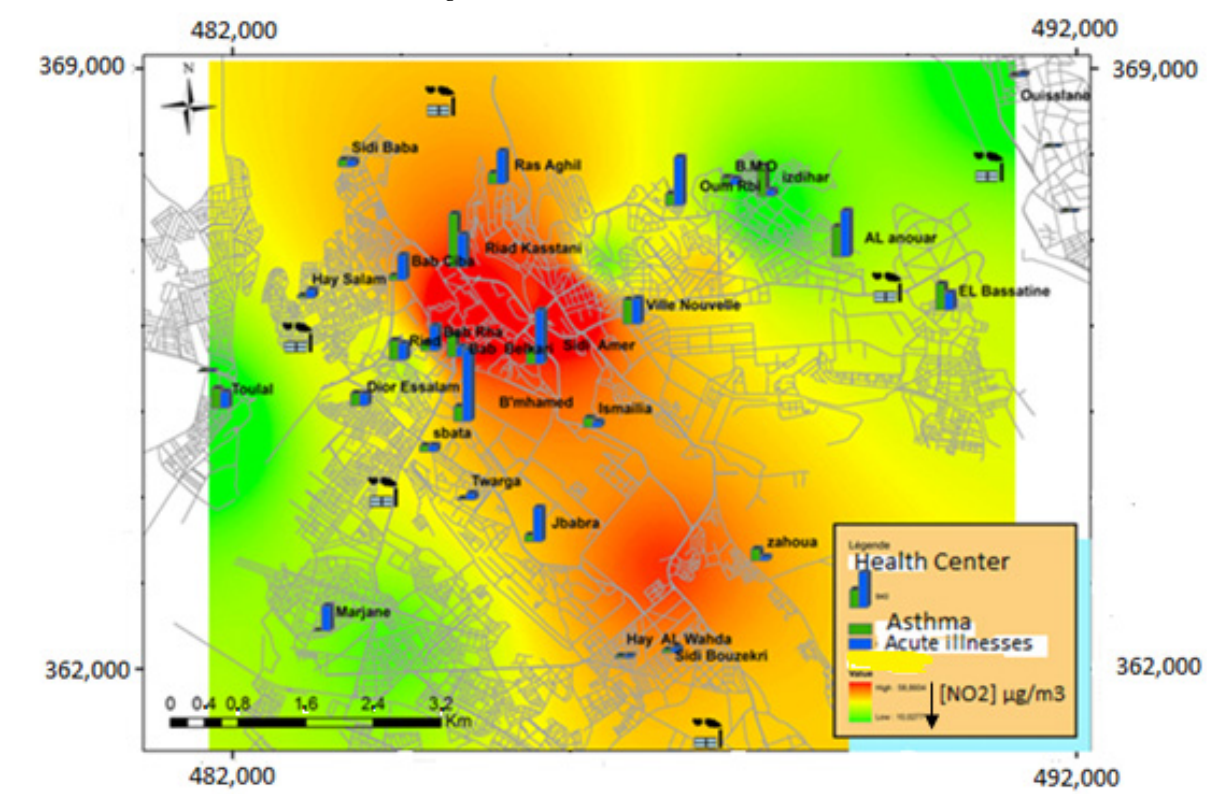
Figure 8. Average annual incidences of consultations in subjects over five years of age by health center overlaid with NO 2 levels.